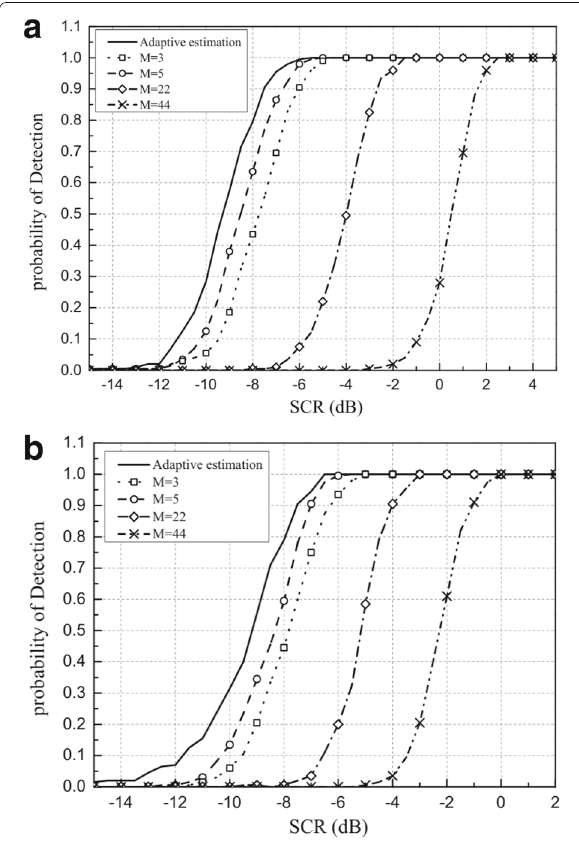
Fig. 8 Performance comparison of three detectors for target 1 and target 2. a target 1; b target 2